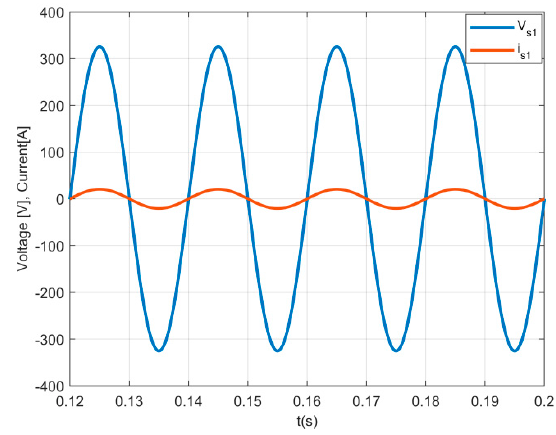
Figure 6. The grid voltage and current in phase 1.